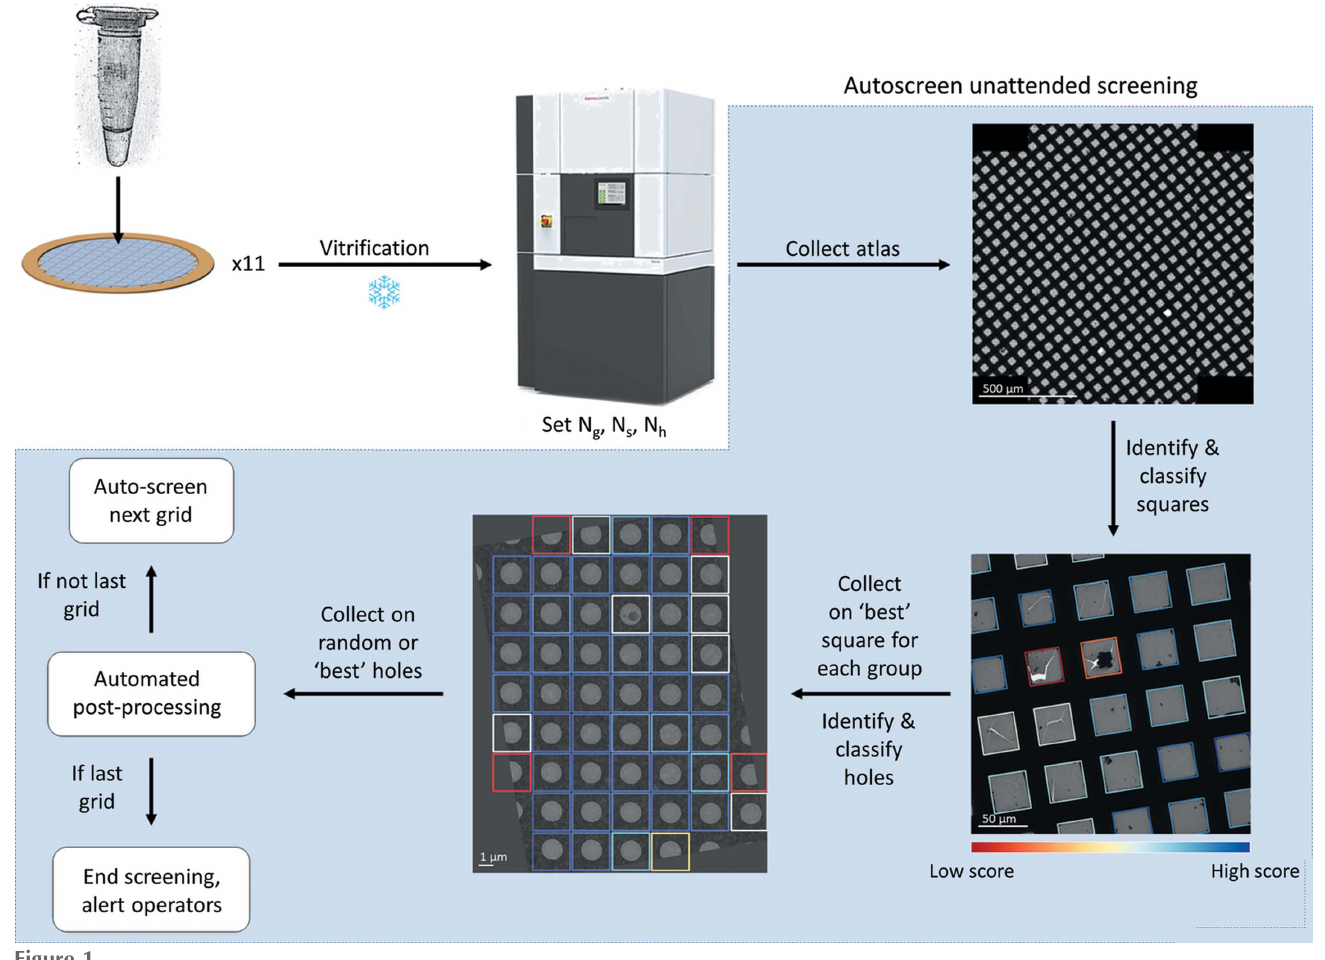
Figure 1 General Smart Leginon Autoscreen fully automated, unattended multi-grid screening workflow. CryoEM grids with samples are prepared and loaded into a cryoTEM with an automated specimen-exchange system. In Autoscreen , the microscope operator imports settings from an example session, including (1) N g , the number of groups to separate the squares in the grid atlas by, based on square area, mean intensity or Ptolemy score; (2) N s , the total number of squares that will be collected; and (3) N h , the number of holes that will be collected for each square. For each grid in the microscope, Smart Leginon Autoscreen will automatically target the highest-ranked (‘best’) square in each group and sample N h random, threshold-filtered holes for each square, where Ptolemy determines rankings. Exposure magnification ice thickness estimations are determined in real time by Leginon and automated pre-processing in Appion ( e.g. frame alignment and CTF estimation) is initiated at the end of each grid collection. If another grid is listed for screening, then Autoscreen automatically moves to the next grid and initiates a new collection session in the database. Once all grids are screened, Autoscreen safely returns the microscope to its default state and sends a message of completion to a designated Slack channel to alert operators and users. Each step in Autoscreen may be performed unattended by command line or used as independent modules in the Leginon GUI. Atlas scale bar